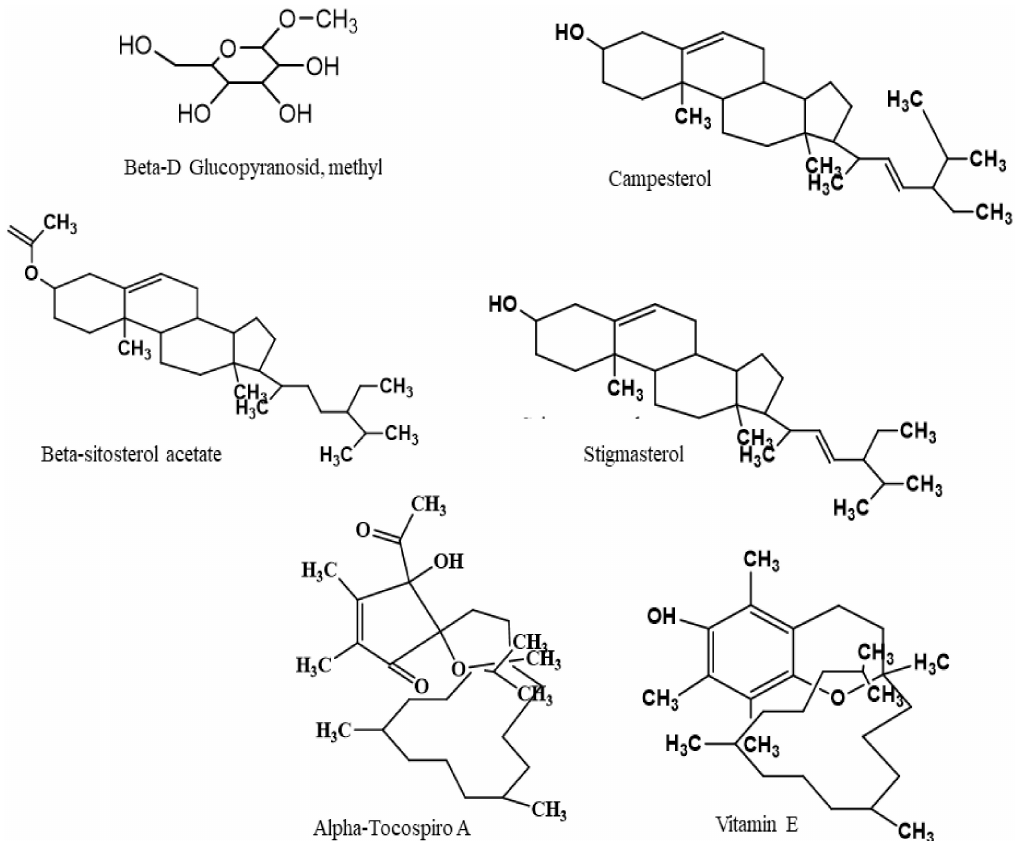
Figure 12. Chemical structures of the major six compounds identified based on the computational study. Table 7. Physicochemical properties of the selected compounds in MEHC for good oral bioavailability. Compound Lipinski